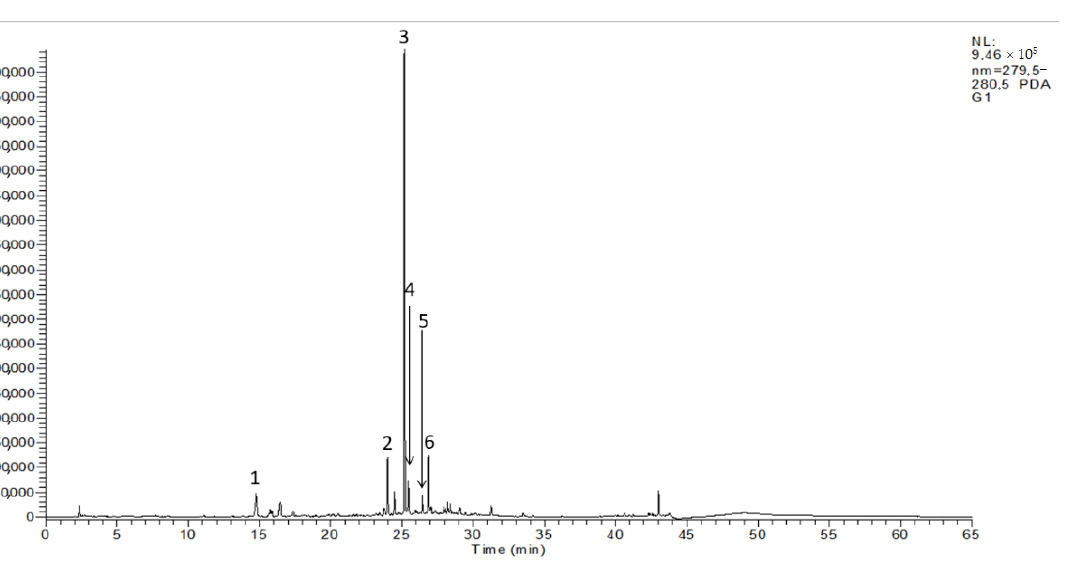
Figure 1. HPLC–DAD chromatogram (280 nm) of olive seeds from ‘Galega’ cultivar: ( 1 ) tyrosol;